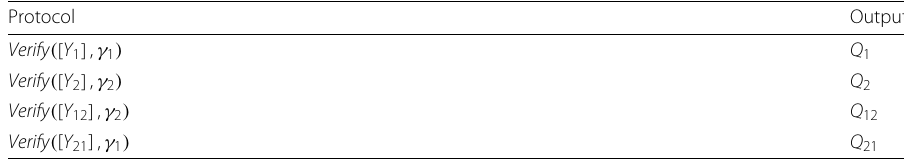
Algorithm 7 Unmask ( [ Y 1 ] , K )